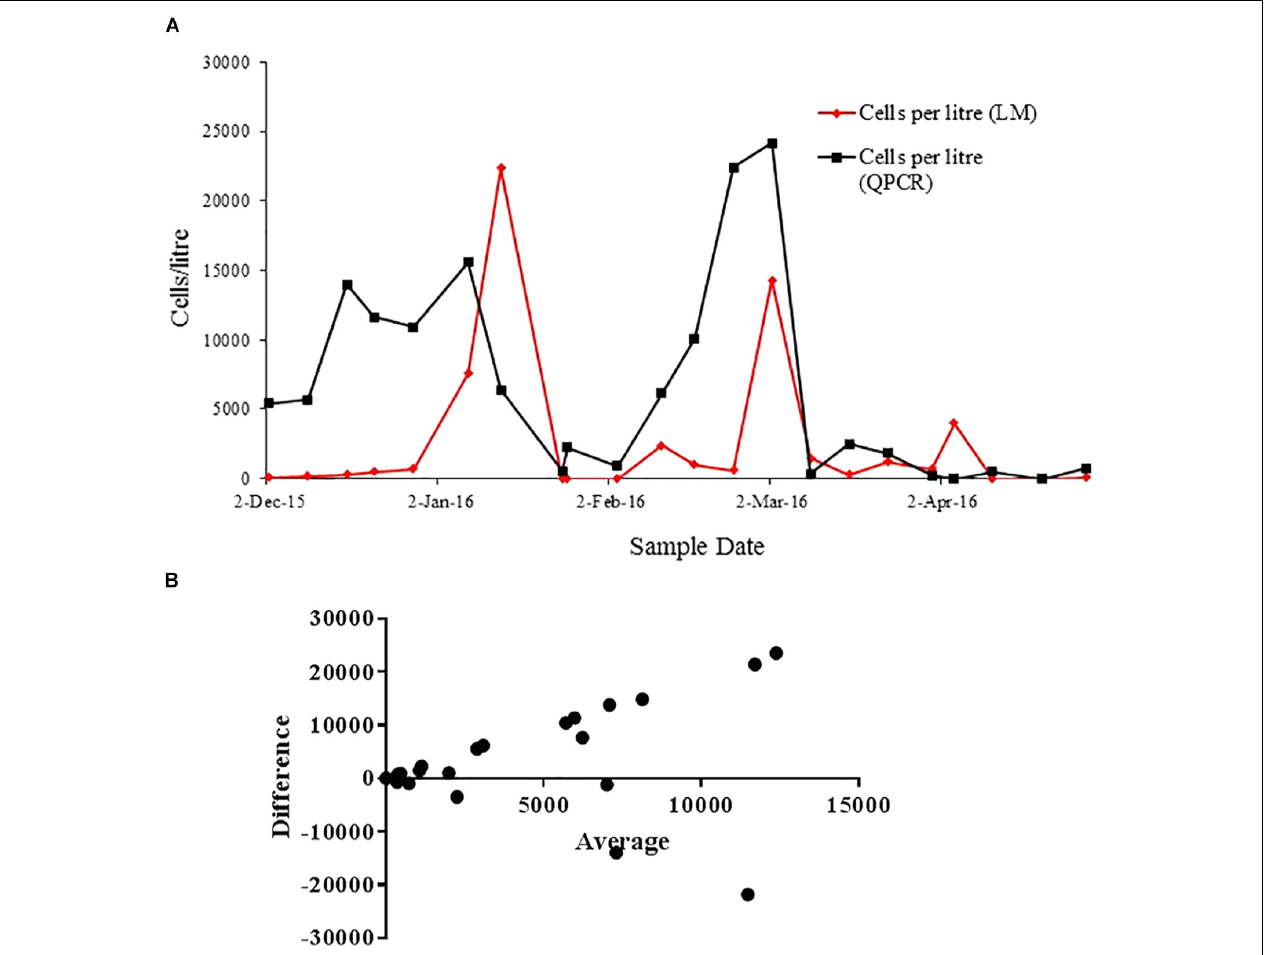
FIGURE 6 | (A) Correlation of cells quantification with light microscopy (red line) and qPCR method (black line) throughout the A. pacificum bloom in Opua Bay, Marlborough Sound. (B) Bland-Altman measurement of agreement between cell quantification using light microscopy and species-specific qPCR